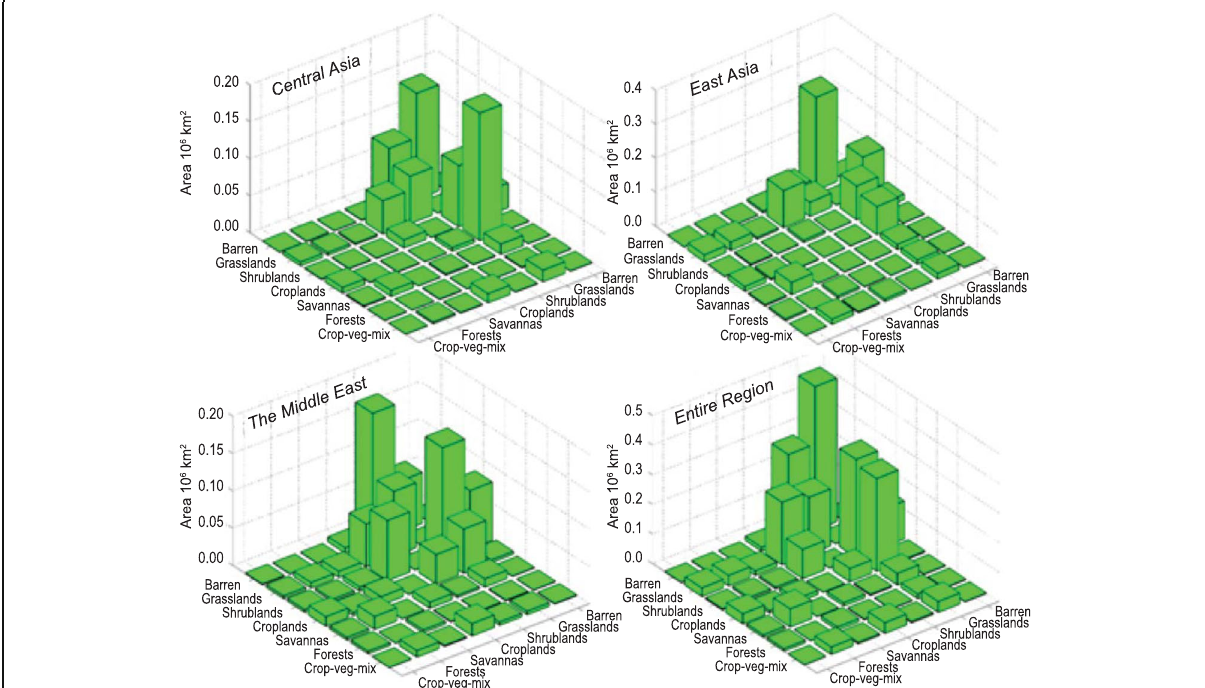
Fig. 14 Land cover change from 2001 to 2012 based on MODIS LC products for the three regions within